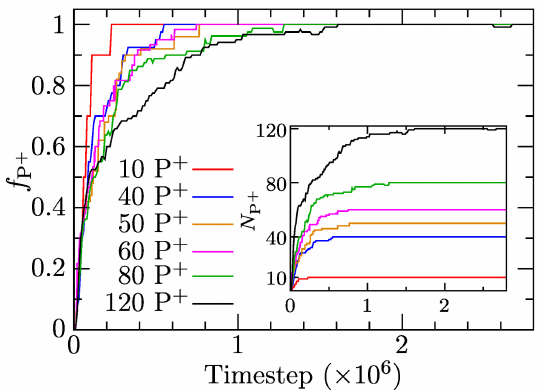
Figure 5. The fraction of porphyrins solubilized in the associates, f time for all systems with added porphyrin. Insert: the number of solubilized porphyrins, N function of time.